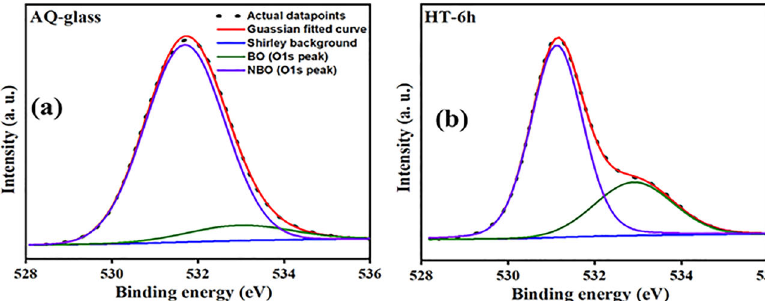
Fig. 5 Estimating bridging (BOs) and non-bridging oxygens (NBOs). a XPS O1s scan obtained for AQ-glass, and b XPS O1s scan obtained for HT-6h samples. XPS O1s scan clearly shows the decrease in NBO/BO ratio in case of HT-6h sample in comparison to